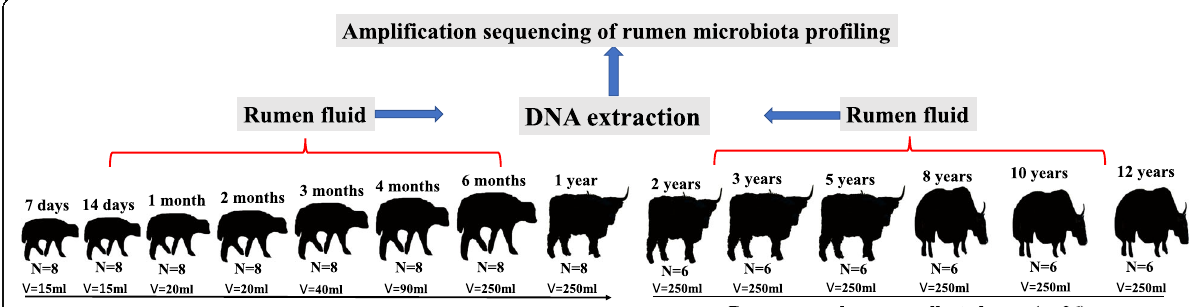
Fig. 1 Experimental design for rumen sample